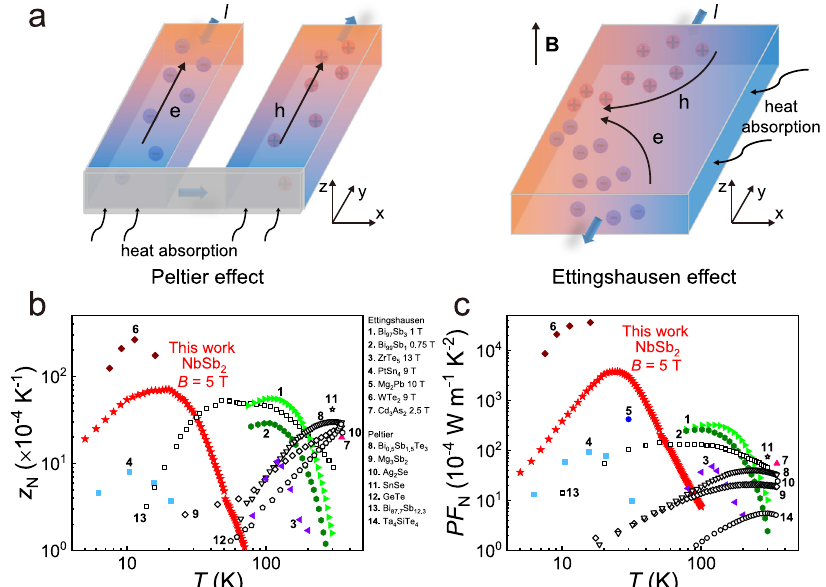
Fig.1|PeltiereffectandEttingshauseneffect.a SchematicdiagramsofthePeltier effectandEttingshauseneffect.Comparisonof b theNernst fi gure-of-merit( z N )and c Nernstpowerfactor( PF N )forsingle-crystallineNbSb 2